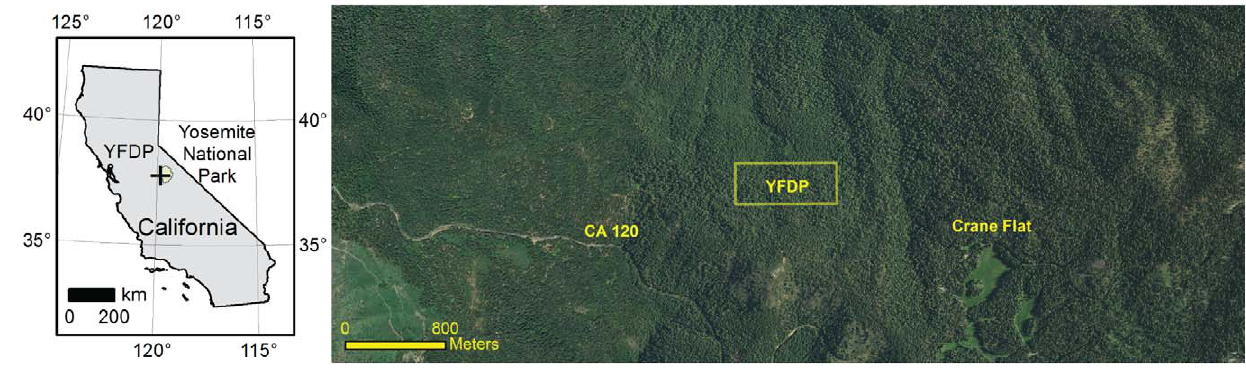
Figure 6. Location of the Yosemite Forest Dynamics Plot (YFDP). The YFDP is located near the western boundary of Yosemite National Park (left, green) in the lower montane, mixed-conifer zone of the Sierra Nevada, California, USA. The plot is located in relatively uniform, late-successional forest near Crane Flat (right). The area immediately north of the YFDP was logged in the early 1930s, as was the area comprising the western 1/3 of the image.